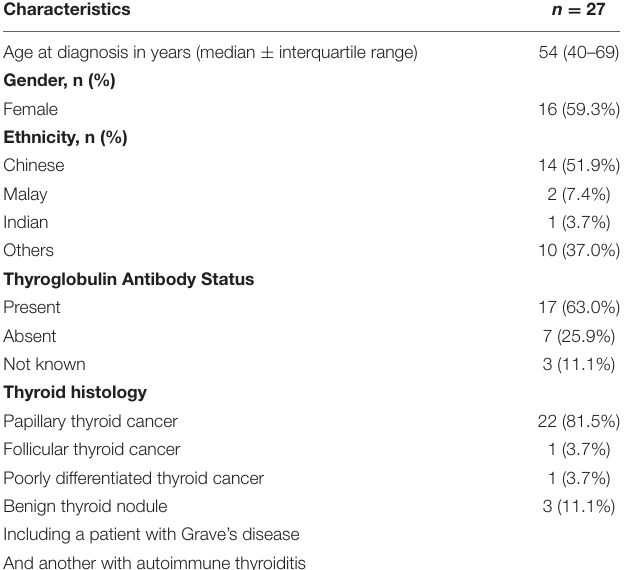
TABLE 1 | Baseline characteristics of patients.